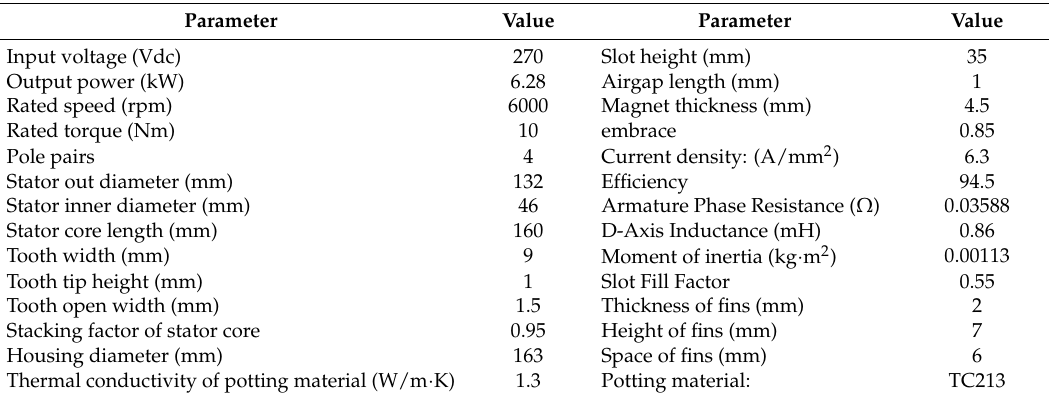
Table 1. Main parameters of the original